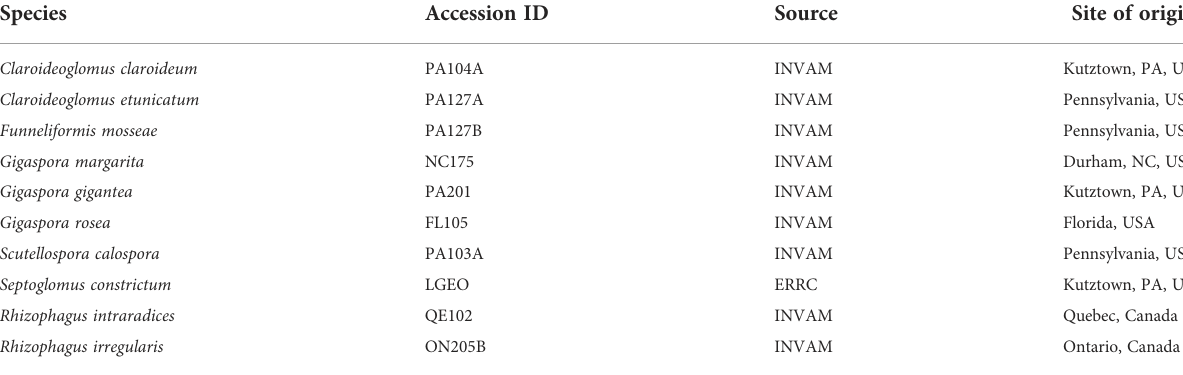
TABLE 1 Fungal isolates used to create single-species inoculant.